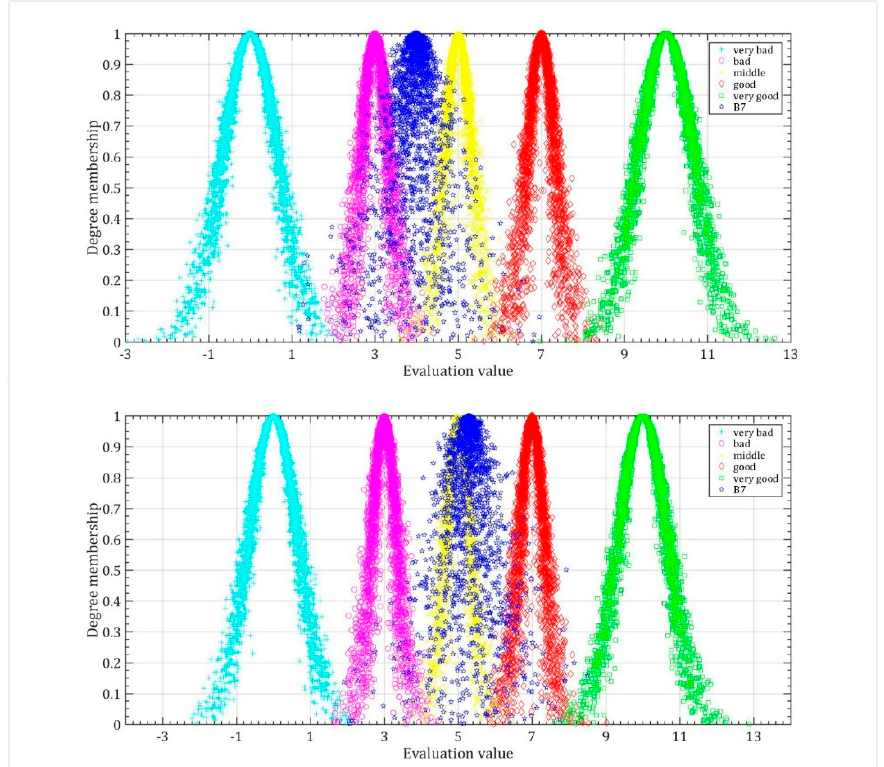
Figure 16. Cloud image of welfare evaluation grades of political participation of land-lost farmers’ households under di ff erent livelihood assets 5.